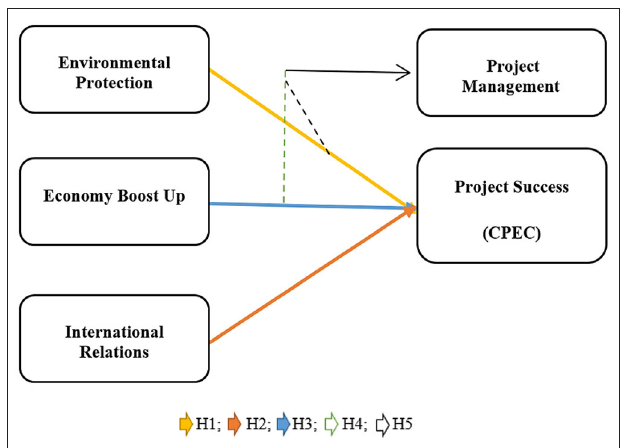
FIGURE 1 | Hypothesis development and study framework.